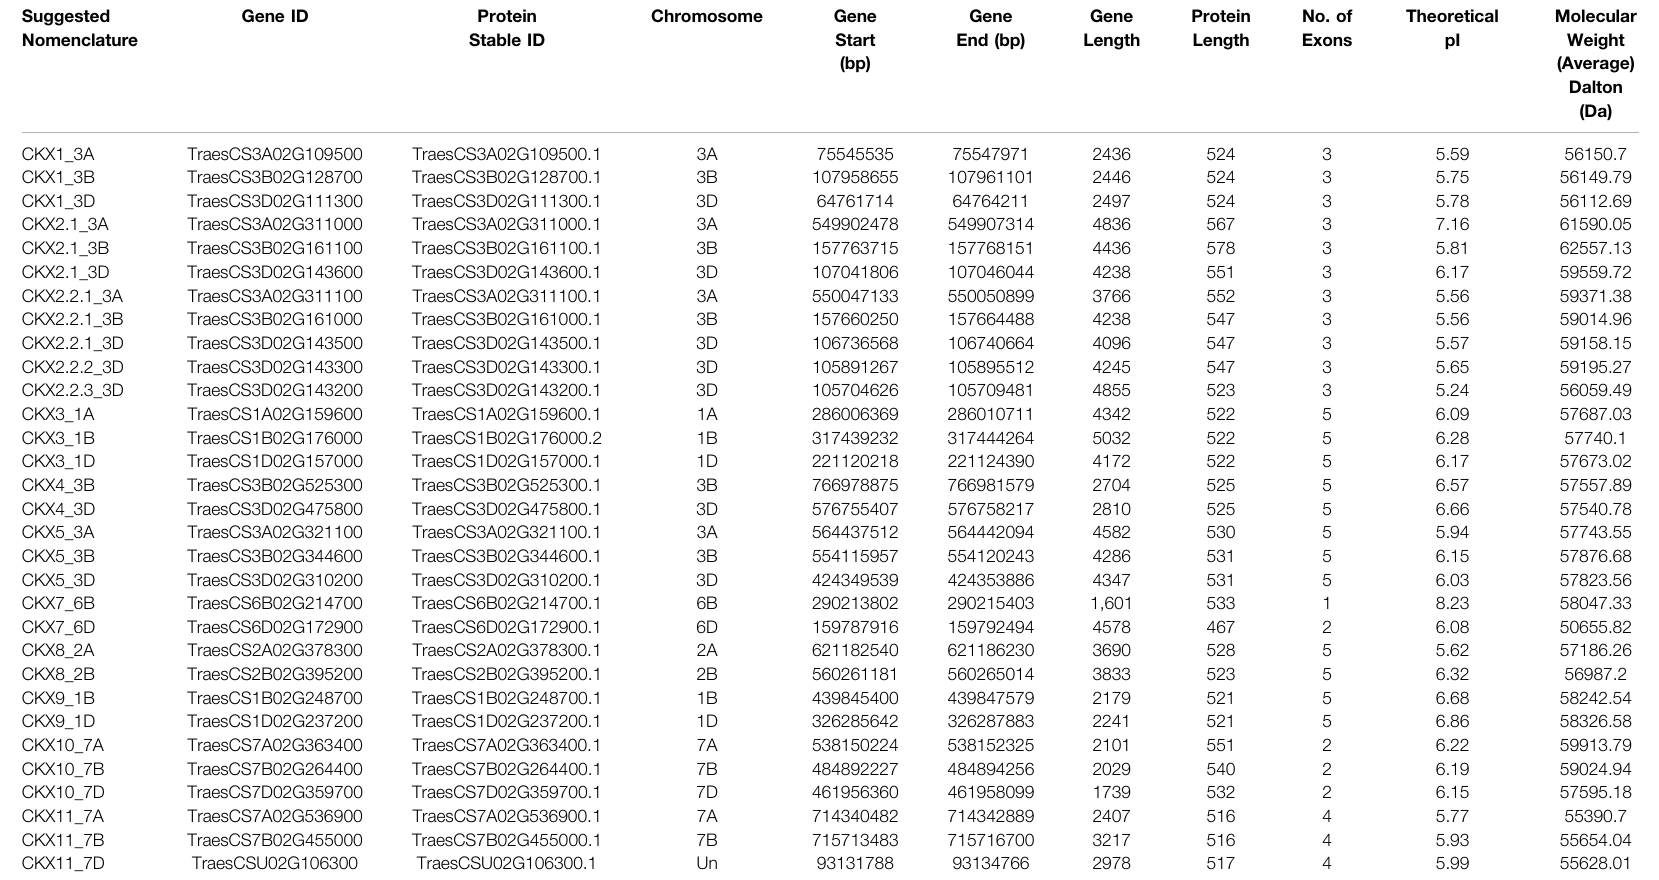
TABLE 1 | Detailed information of the cytokinin dehydrogenase gene family ( Triticum aestivum ) with respect to their chromosomal location and general protein parameters. Suggested